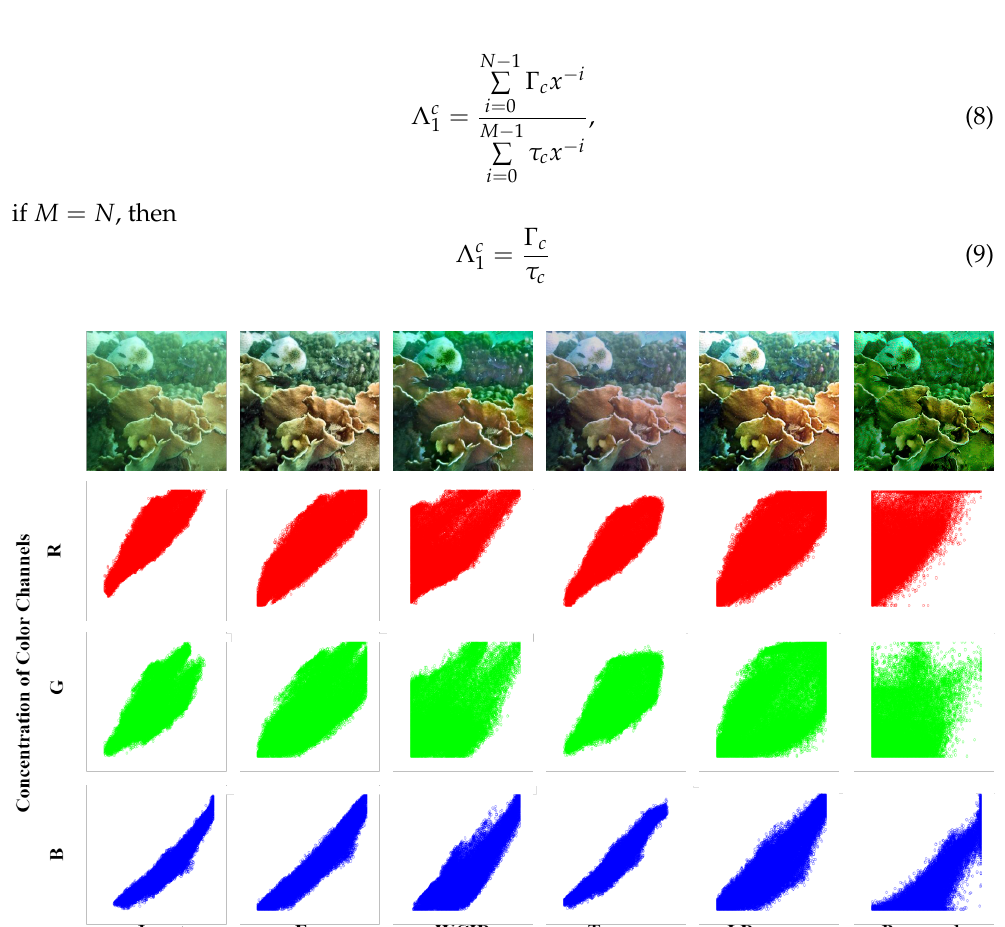
Figure 2. A summary of the effectiveness of including the transmission map function to extract more color channels compared to existing techniques. From left to right are the raw underwater images, results from Fus [32], WCID [33], Ts [34], LD [35] and proposed results. Image, R, G, B color channel concentration are shown from top to